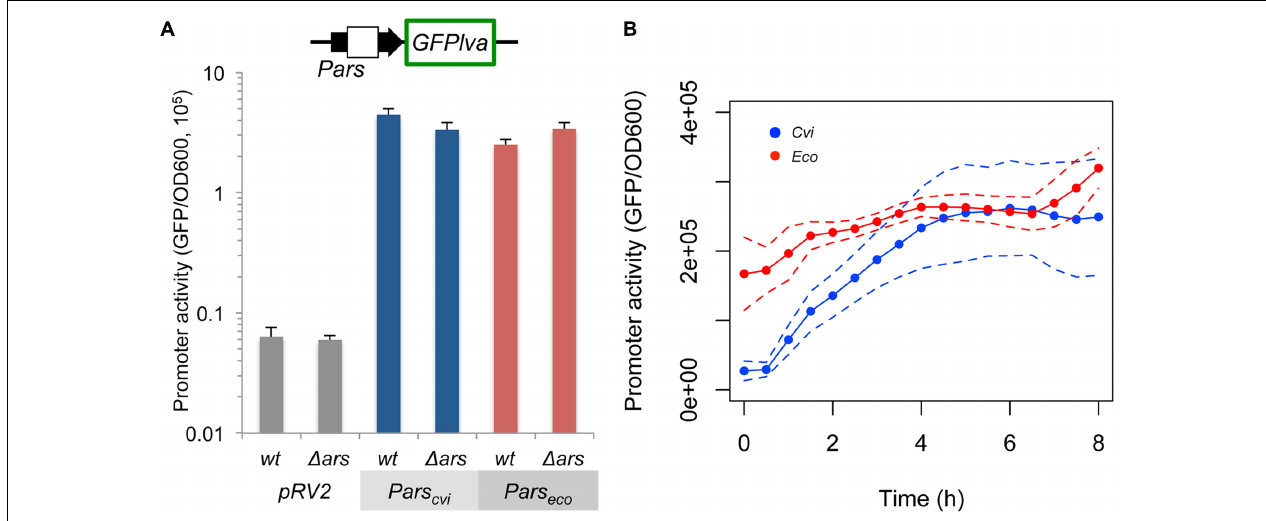
FIGURE 2 | Quantification of the intrinsic Pars cvi and Pars eco activities. Wild type (wt) E. coli or mutant ( (cid:49) ars ) strains harboring the reporter plasmids containing the GFPlva gene under the control of the specific promoters were assayed in M9 media in the absence of As III . Empty pRV2 plasmid was used as control. (A) Maximal activity of the specific promoter after 6 h of growth. (B) Promoter dynamics during growth of E. coli AW3110 ( (cid:49) ars ) harboring pRV2- Pars cvi (Cvi, blue) or pRV2- Pars eco (Eco, red). Solid lines represent the average of three independent experiments, whereas dashed lines represents the upper and lower limits of standard deviations.